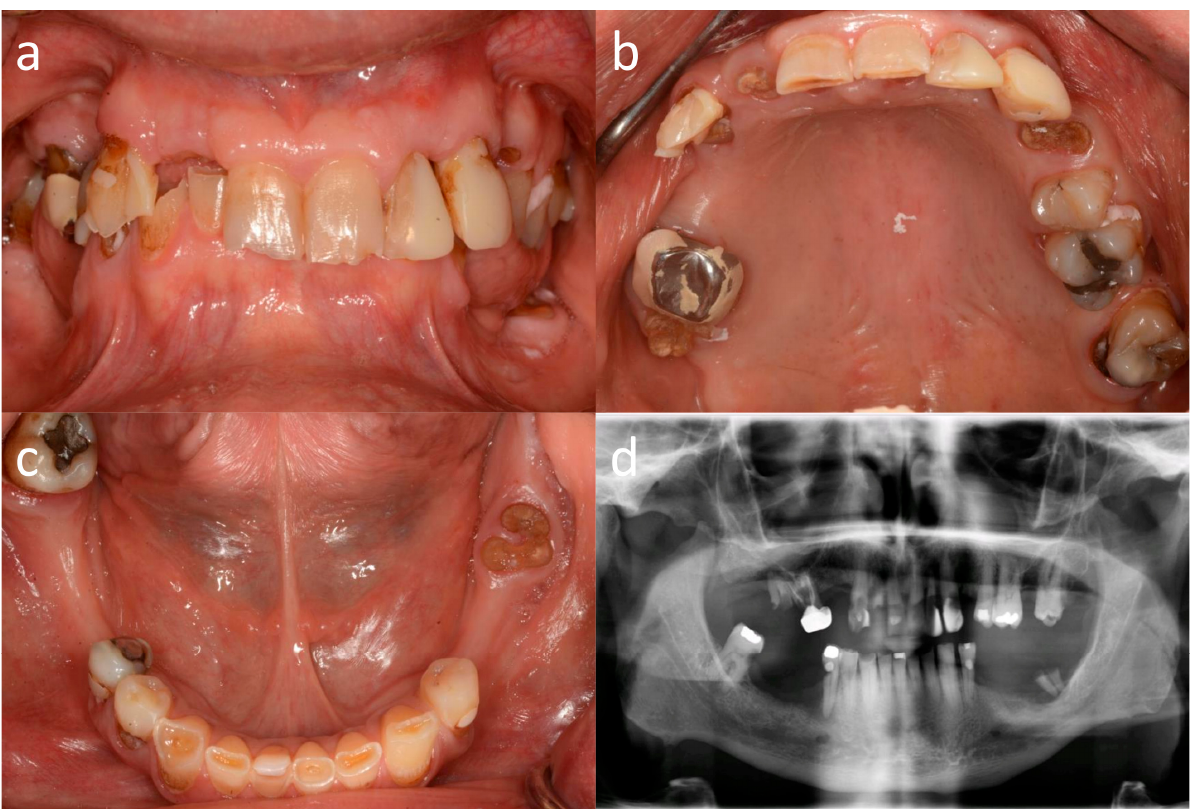
Figure 2. Initial situation. ( a ) Frontal view; ( b ) occlusal view of the maxillary arch; ( c ) occlusal view of the mandibular arch; ( d ) panoramic radiograph.